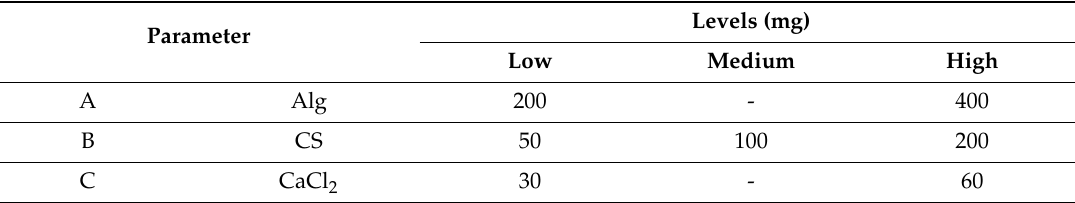
Table 1. Independent parameters and their